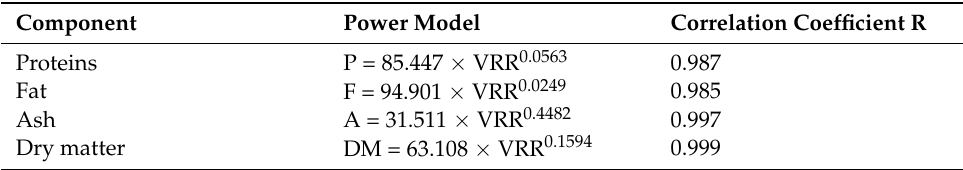
Table 2. Power models for rejection factor of buttermilk components depending on the volume reduction ratio.